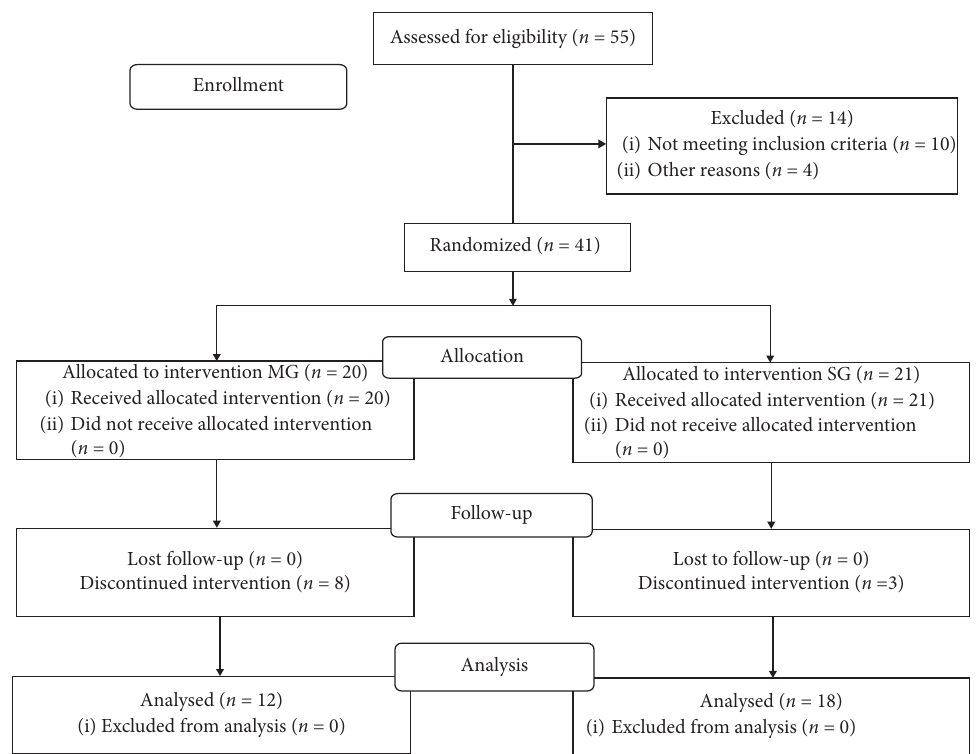
Figure 1: Consort flow diagram. MG: multicomponent group; SG: strength